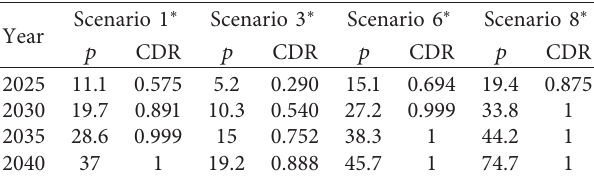
Table 3: Covered demand ratio for different